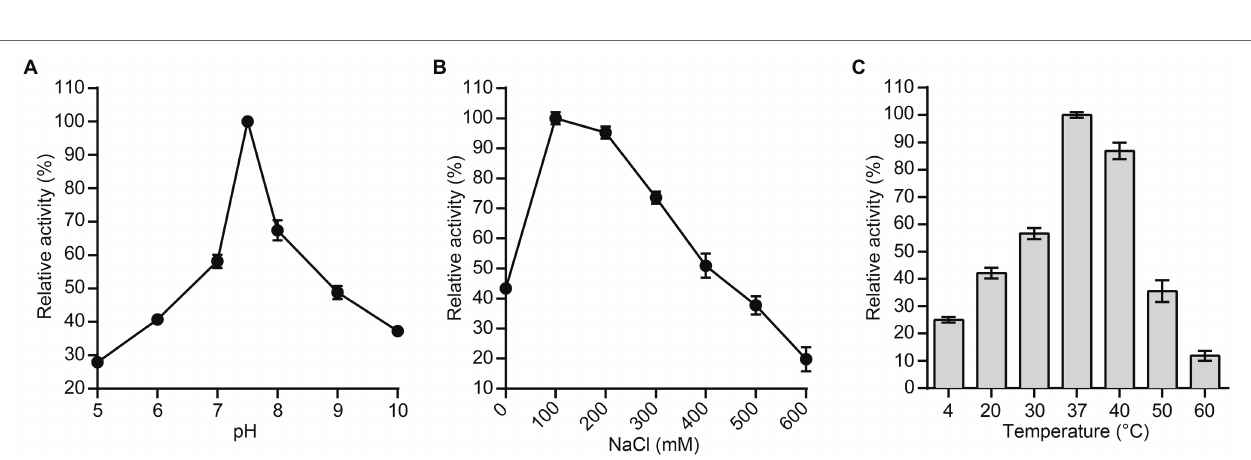
FIGURE 4 | Validation of the biological activity of recombinant P9ly, which manifests as bacterial cell wall (CW) digestion and the exertion of inhibitory effects toward Gram-negative Escherichia coli and Gram-positive Staphylococcus aureus . (A) P9ly can digest the CW obtained from Shigella dysenteriae KUST9, the host bacterium for phage PSD9. (B) Inhibitory zones of recombinant P9ly against Gram-negative E. coli and Gram-positive S. aureus . Phosphate-buffered saline (PBS) buffer and 100 μ g/ml kanamycin were used as negative and positive controls, respectively. *** indicates p < 0.001; NS, not